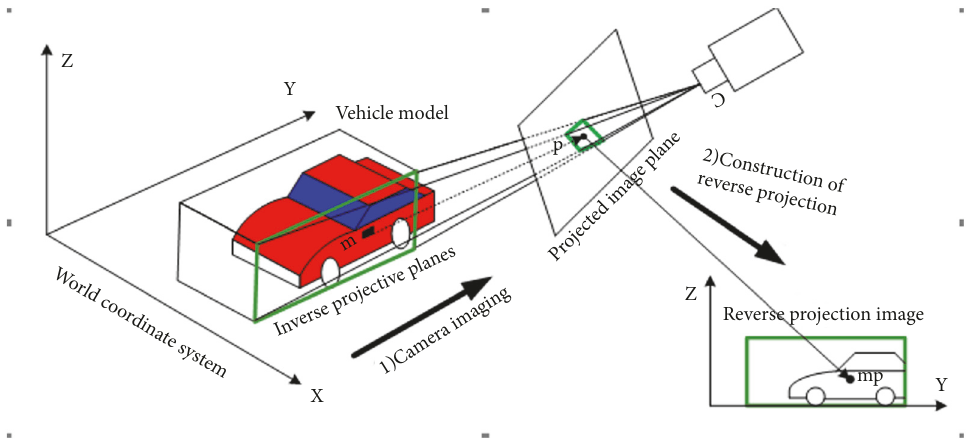
Figure 48: Construction of the inverse projection. Table 2: Parking detection results in different